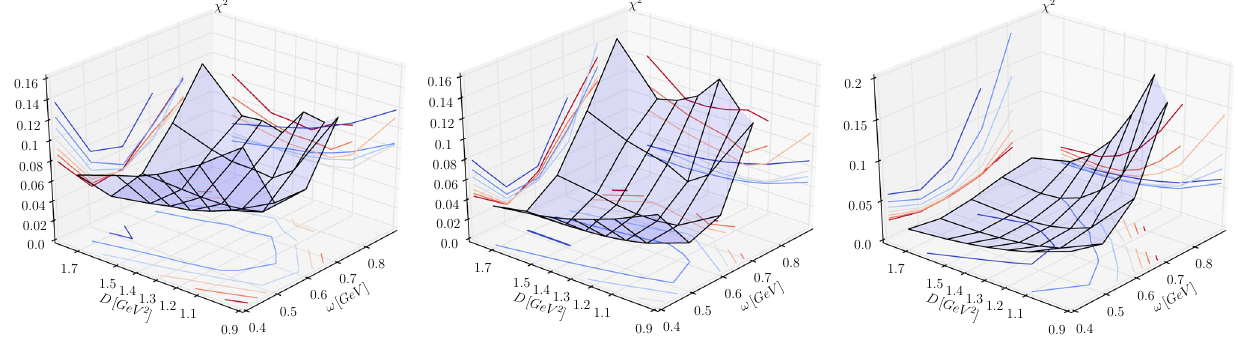
Fig. 15 χ 2 plot from the comparison of our calculated and the experimental pion-related splitting as a function of ω and D . Left panel Combination of all pion-related splittings (see text); center panel combination of a subset of 5 splittings (see text); right panel ( [ 1 −− ] 0 −+ 0